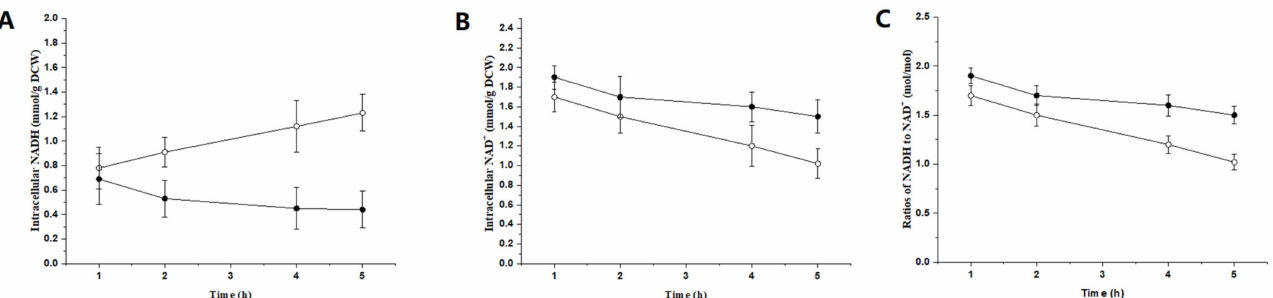
Figure 8. Effects of NAD+ regeneration system on levels of intracellular NADH, NAD+ and ratios of NADH to NAD+ Circular (Solid) represents Serratia marcescens MG1ABC (pSWNB+pETDuet-bdhA-yodC). Circular (Hollow) represents Serratia marcescens MG1ABC (pSWNB+pETDuet-yodC). ( A ) Effects of NAD+ regeneration system on levels of intracellular NADH; ( B ) Effects of NAD+ regeneration system on levels of intracellular NAD+; ( C ) Effects of NAD+ regeneration system on ratios of NADH to NAD+.